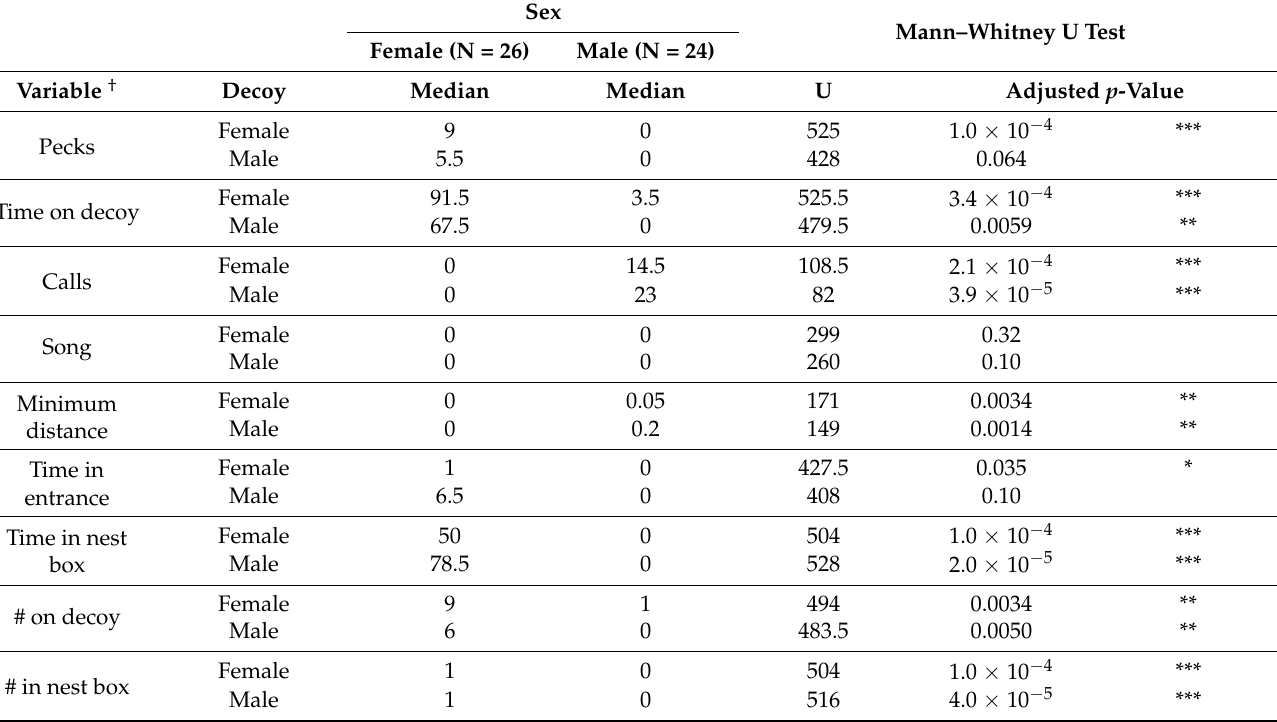
Table A3. Results of Mann–Whitney U tests comparing how female and male blue tits (N Female = 26; N Male = 24) responded to same-sex and opposite-sex rivals for the different behaviours considered. The median, test statistic and adjusted p -values with the Holm correction for multiple testing are presented [43]. Asterisks indicate level of statistical significance: * p ≤ 0.05, ** p ≤ 0.01, *** p ≤ 0.001.